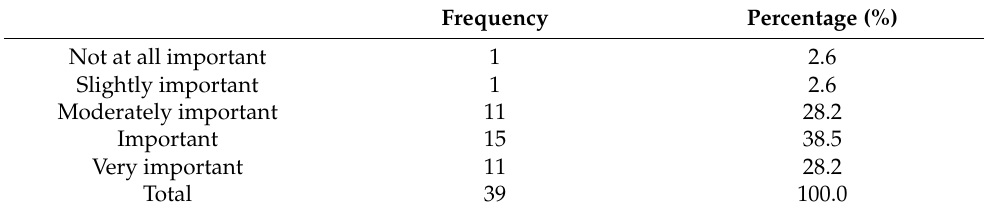
Table 11. Frequency and percentage units regarding public access to Hub’s information ( N = 39). Frequency Percentage (%) Not at all